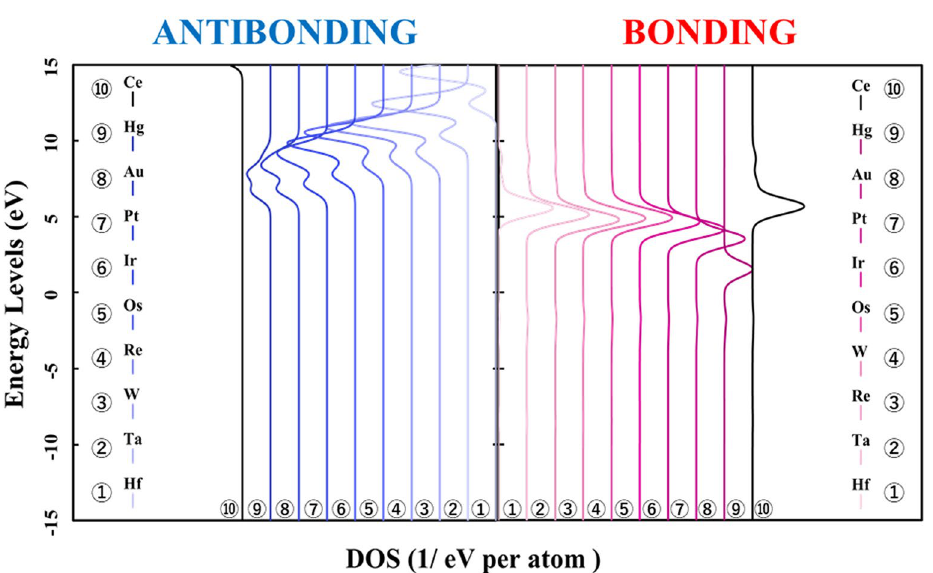
Figure 11. Energy levels of the bond composition between the metal 5d orbitals and the oxygen 2p orbitals are based on the reference level as the vacuum level in the M@Ce 12 O 836+ cluster model (M = Hf, Ta, W, Re, Os, Ir, Pt, Au, Hg). The bond composition between the metal 5d orbitals and the oxygen 2p orbitals are in the undoped ceria. The bonding and antibonding orbital components are on the right and left sides,